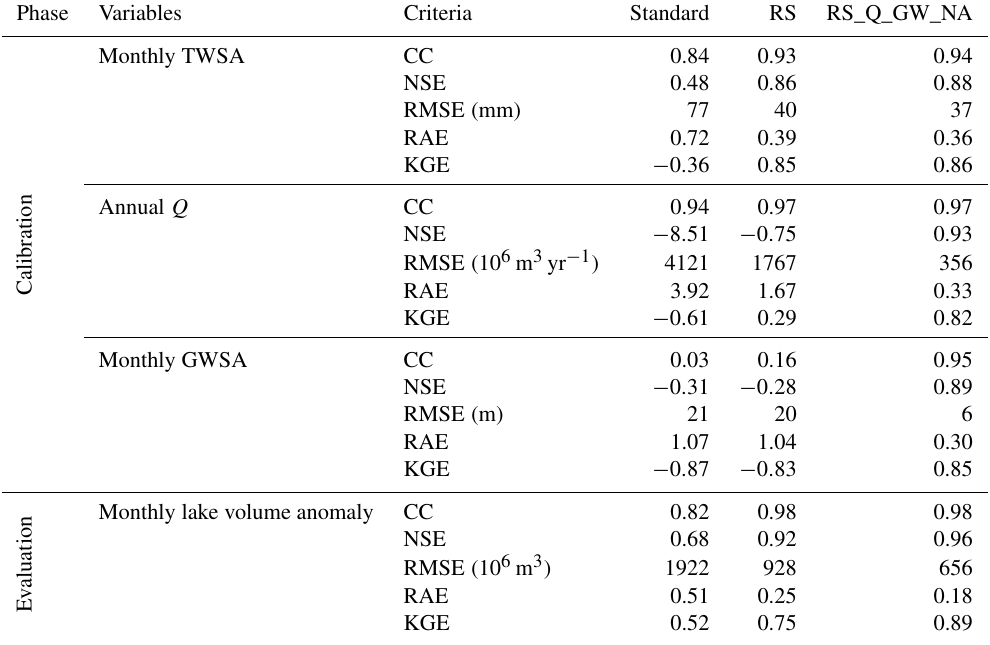
Table 2. Performance of standard and calibrated WGHM variants with respect to observations of TWSA, inflow to lake, GWSA and lake volume